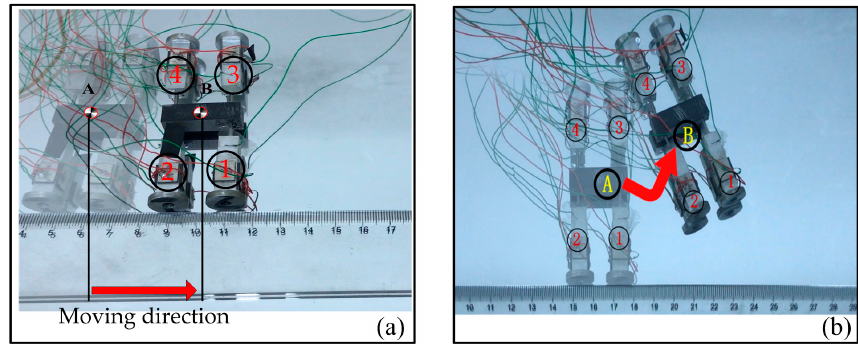
Figure 7. Movement test of the robot: (a) Linear motion; (b) Turning motion.